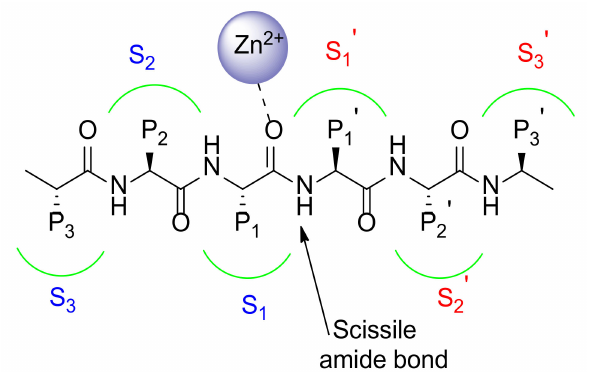
Figure 3. Schematic representation of MMP catalytic binding